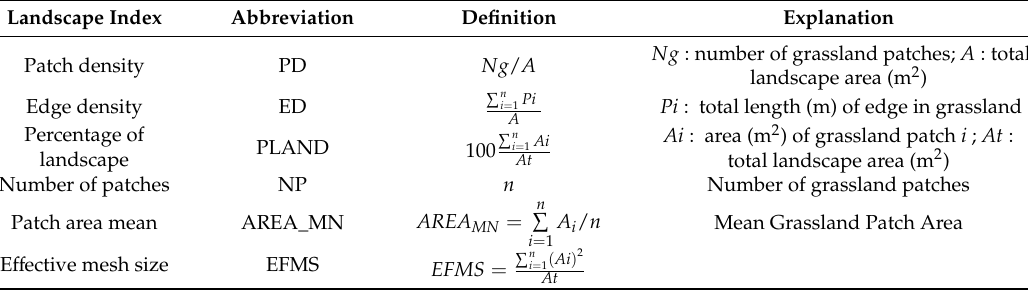
Table 1. Explanation of landscape metrics used in this